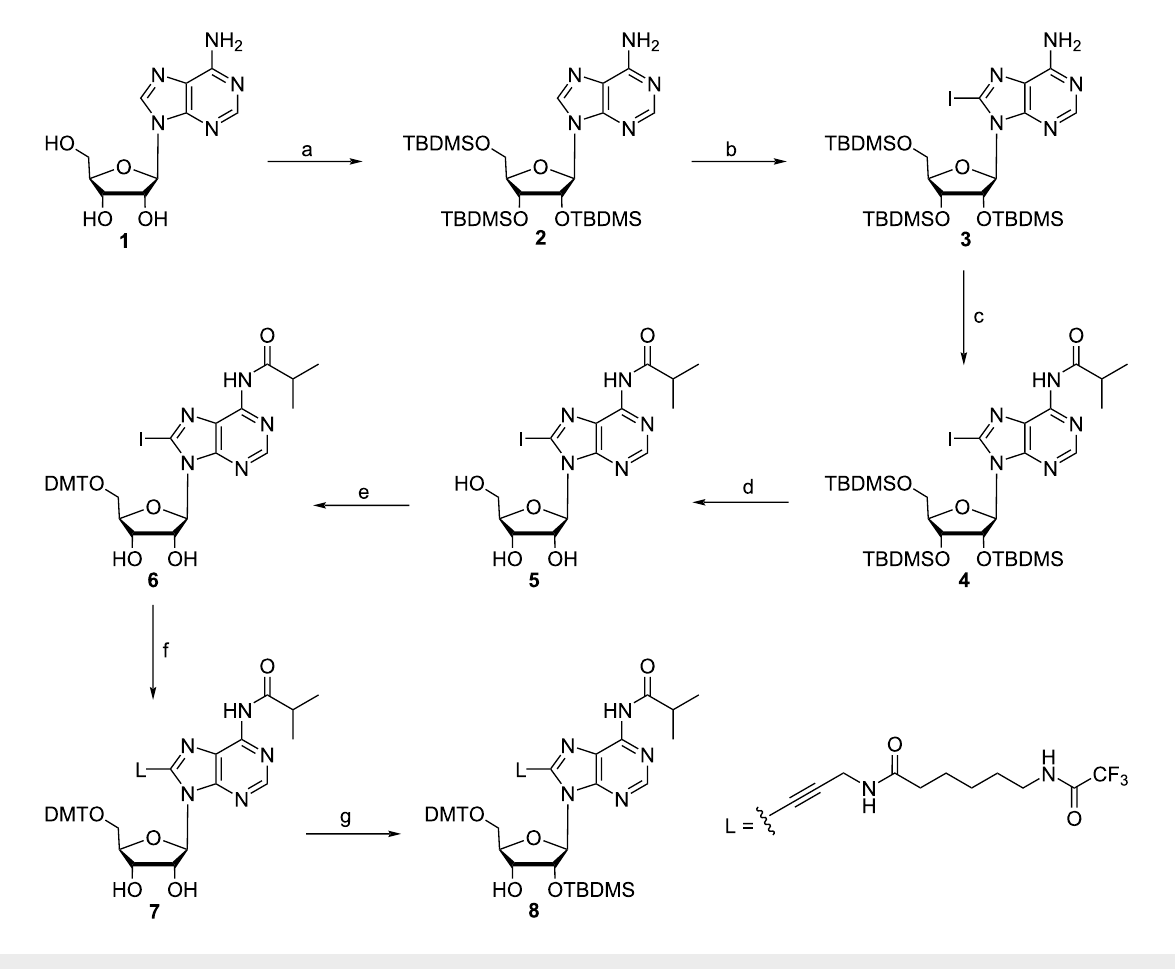
Scheme 1: Synthesis of a C8-linker-modified adenosine derivative. (a) 4 equiv TBDMS-Cl, 5 equiv imidazole, DMF, 60 °C, overnight, 82%; (b) 5 equiv LDA, 1.8 equiv I 2 , 5 equiv acetic acid, THF, − 75 °C, 9 h, 79%; (c) 6 equiv isobutyric anhydride, pyridine, 45 °C, overnight,